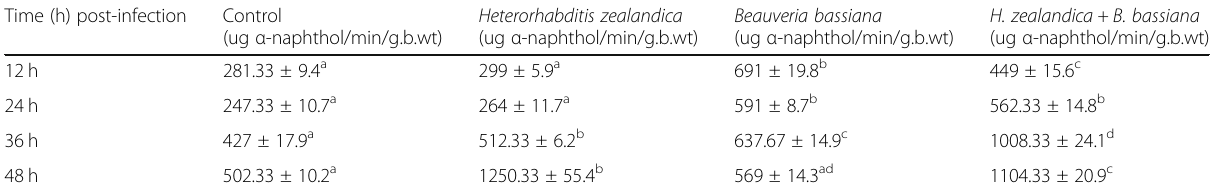
Table 5 Changes in non-specific esterase activity (mean ± SE) of last instar Galleria mellonella larvae at 12, 24, 36, and 48 h post- infection with Heterorhabditis zealandica , Beauveria bassiana , and combination them Time (h) post-infection Control Heterorhabditis zealandica Beauveria bassiana (ug α -naphthol/min/g.b.wt) (ug α -naphthol/min/g.b.wt) (ug α